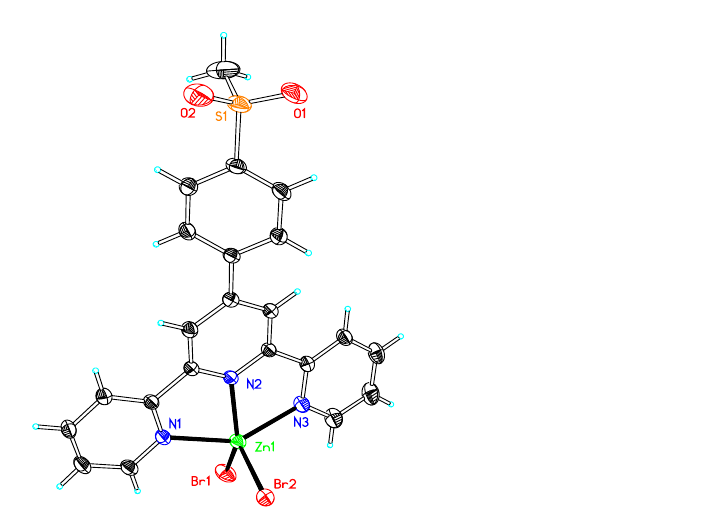
Figure 1. Thermal ellipsoid plot, drawn at the 50% probability level, of [ZnBr 2 L 1 ] (1) with atomic numbering scheme. Selected bond lengths (Å) and angles ( ◦ ): Zn(1)-N(2) 2.099(2), Zn(1)-N(1) 2.187(2), Zn(1)-N(3) 2.215(2), Zn(1)-Br(2) 2.4065(4), Zn(1)-Br(1) 2.4143(4), N(2)-Zn(1)-N(1) 74.22(8) N(2)-Zn(1)-N(3) 74.27(8), N(1)-Zn(1)-N(3) 146.24(8), N(2)-Zn(1)-Br(2) 138.77(6), N(1)-Zn(1)-Br(2)